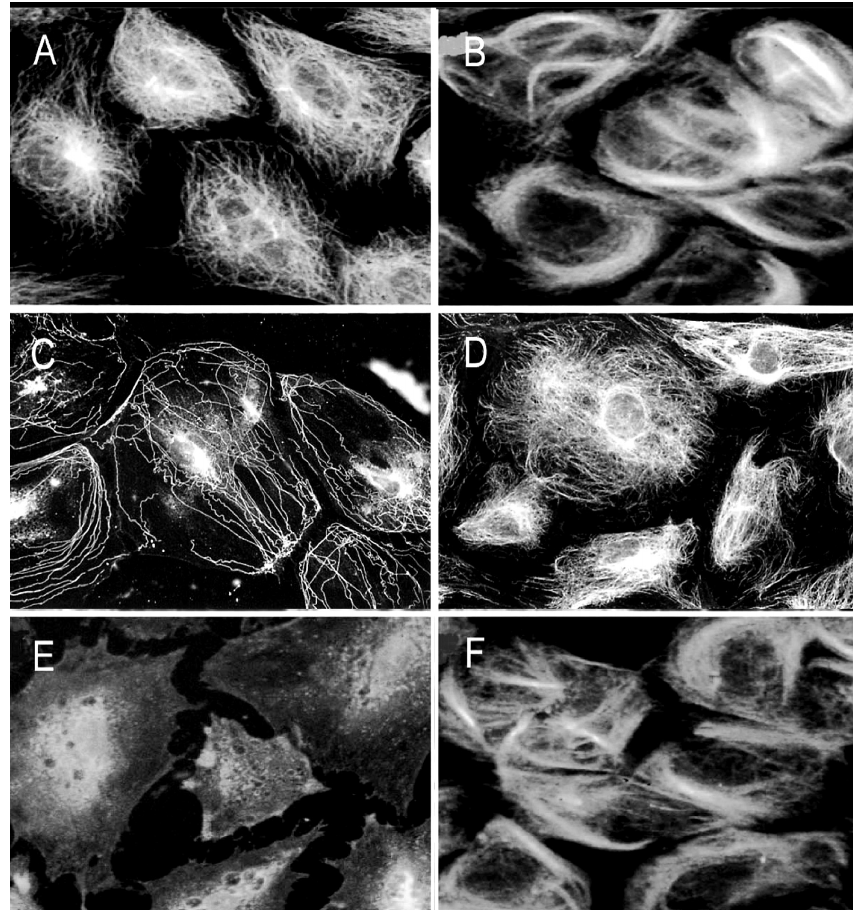
Figure 9. Taxol antagonistic effects on As 3+ -induced MT injury. Growth–arrested RFL6 cells on coverslips were treated with As 3+ , NEM, or their combinations with taxol for 24 h, and then stained with an anti- β tubulin antibody-FITC to visualize MTs. ( A ) control cells; ( B ) cells treated with 20 µM taxol; ( C ) cells treated with 20 µM As 3+ ; ( D ) cells treated with 20 µM As 3+ + 20 µM taxol; ( E ) cells treated with 25 µM NEM; ( F ) cells treated with 25 µM NEM + 20 µM